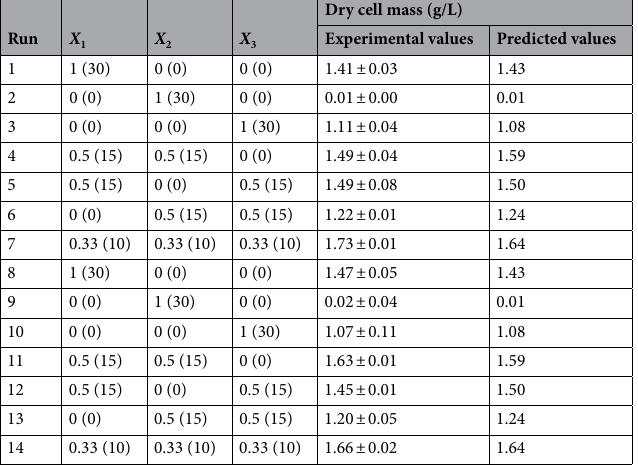
Table 2. Matrix of the simplex centroid design applied to studying the biomass production of L. sakei ACU-2 in the medium containing different nitrogen sources. X 1 Yeast extract (g/L); X 2 WPC (g/L); X 3 Soy peptone (g/L). Where X 1 + X 2 + X 3 = 30 g/L. The dry cell mass was measured after 24 h of incubation. Data are presented as the mean value of independent experiments performed in triplicate and the standard